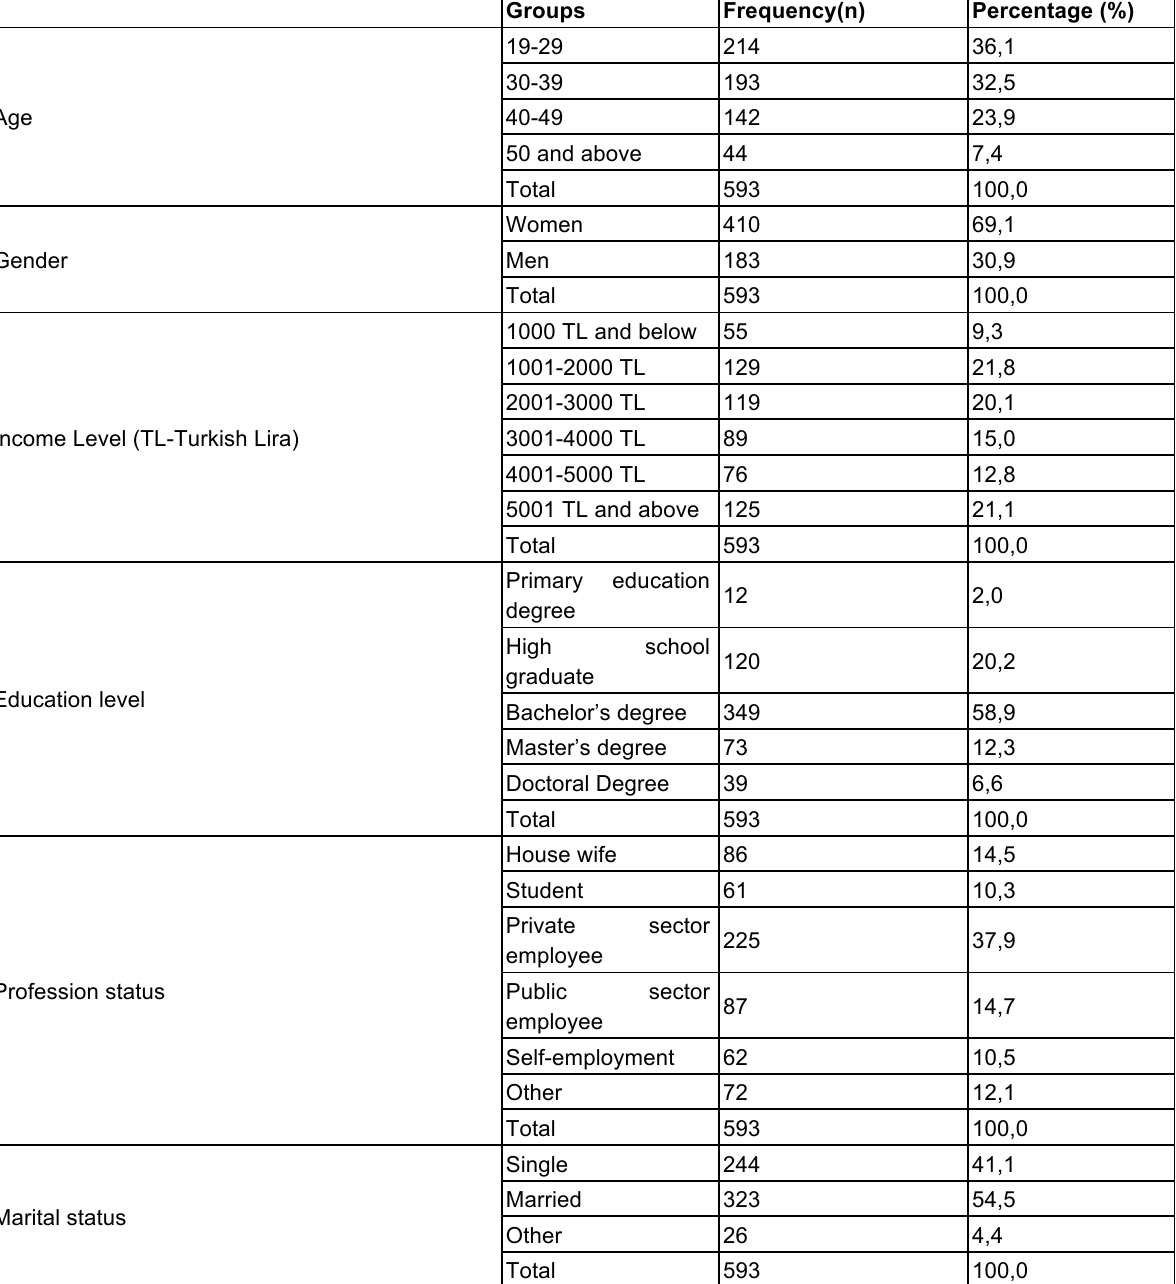
Table 1: Demographic Profile of the